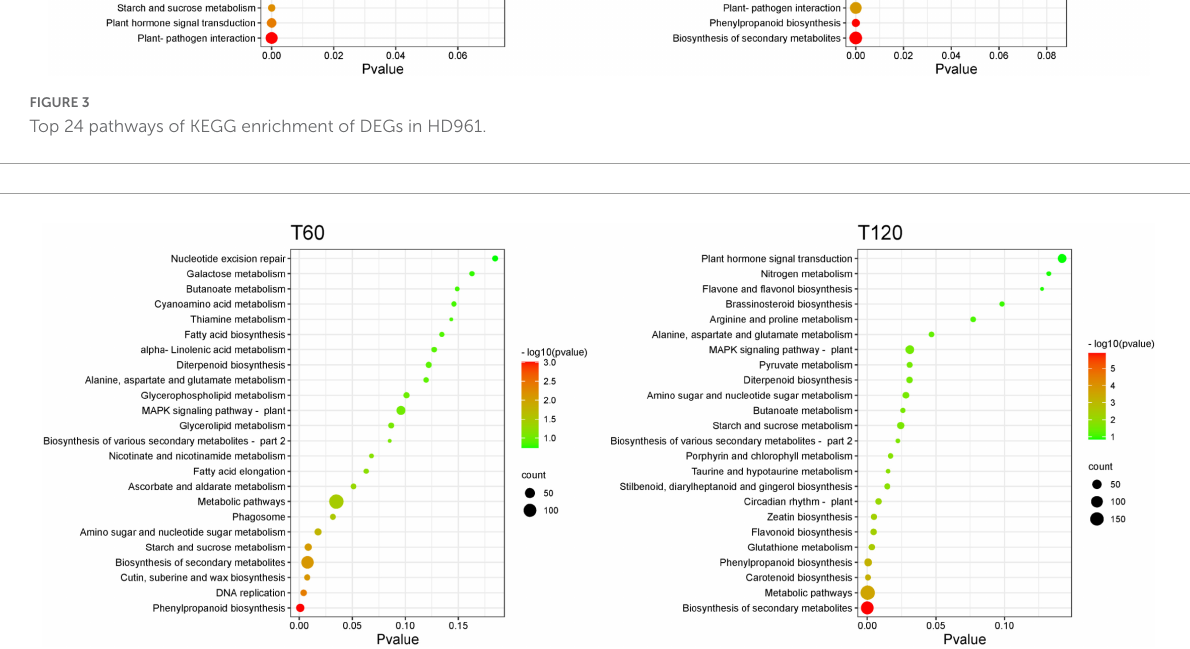
FIGURE4 Top 24 pathways of KEGG enrichment of DEGs in